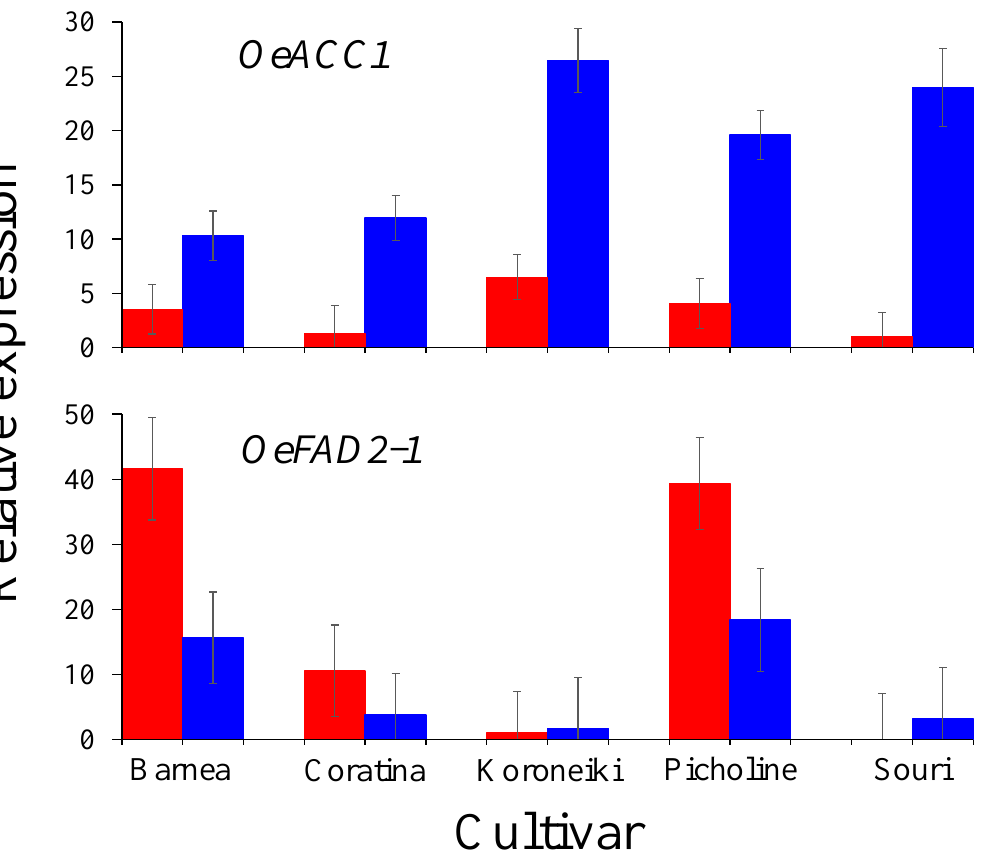
Figure 3. OeACC1 and OeFAD2-1 expression analyzed by RT-PCR at 146 DPA. Relative expression levels of OeACC1 (above) and OeFAD2-1 (below) in the five cultivars ‘Barnea’, ‘Coratina’, ‘Koroneiki’, ‘Picholine’ and ‘Souri’, in HT (red columns) and MT (blue columns) environments. Error bars represent confidence intervals ( p <